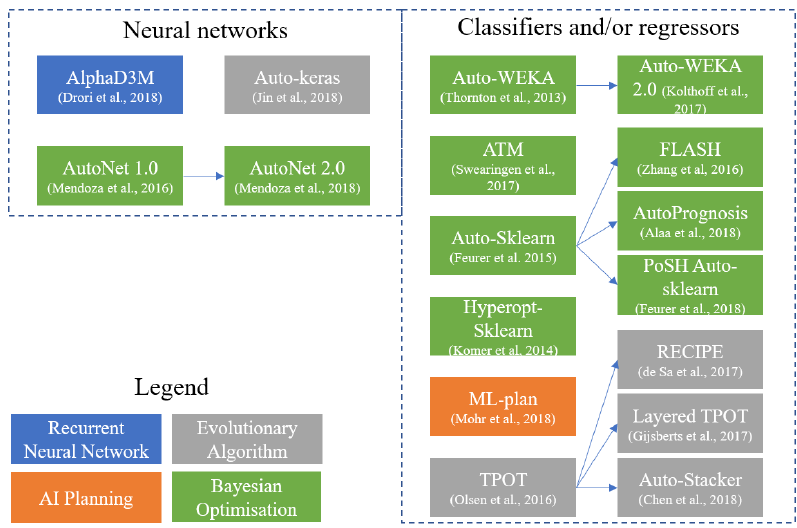
Figure 2. Overview of AutoML methods.